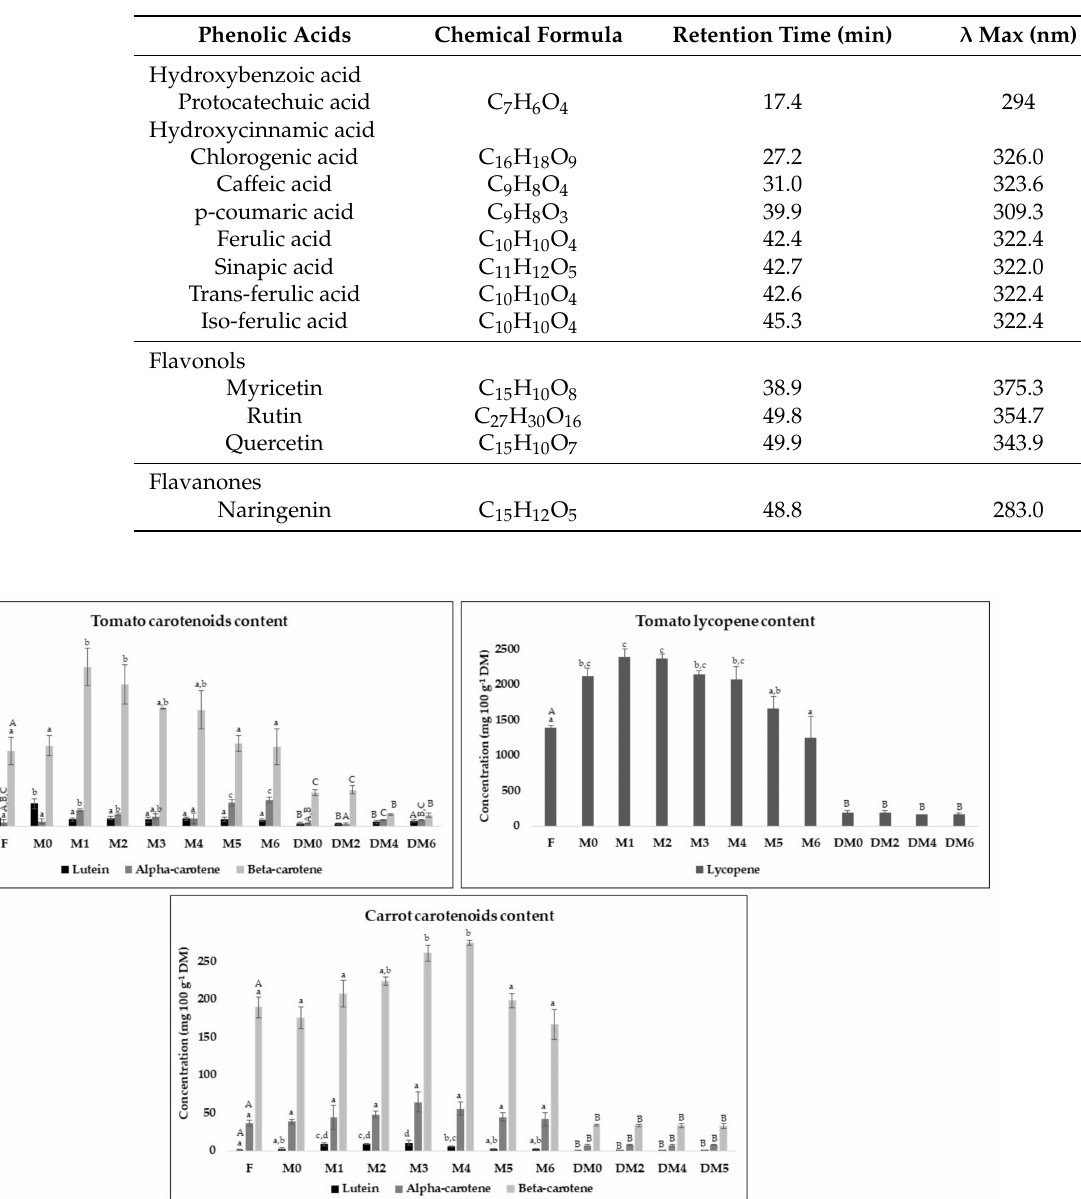
Table 5. Phenolic acids identified in cherry tomato and/or baby carrot by-products.